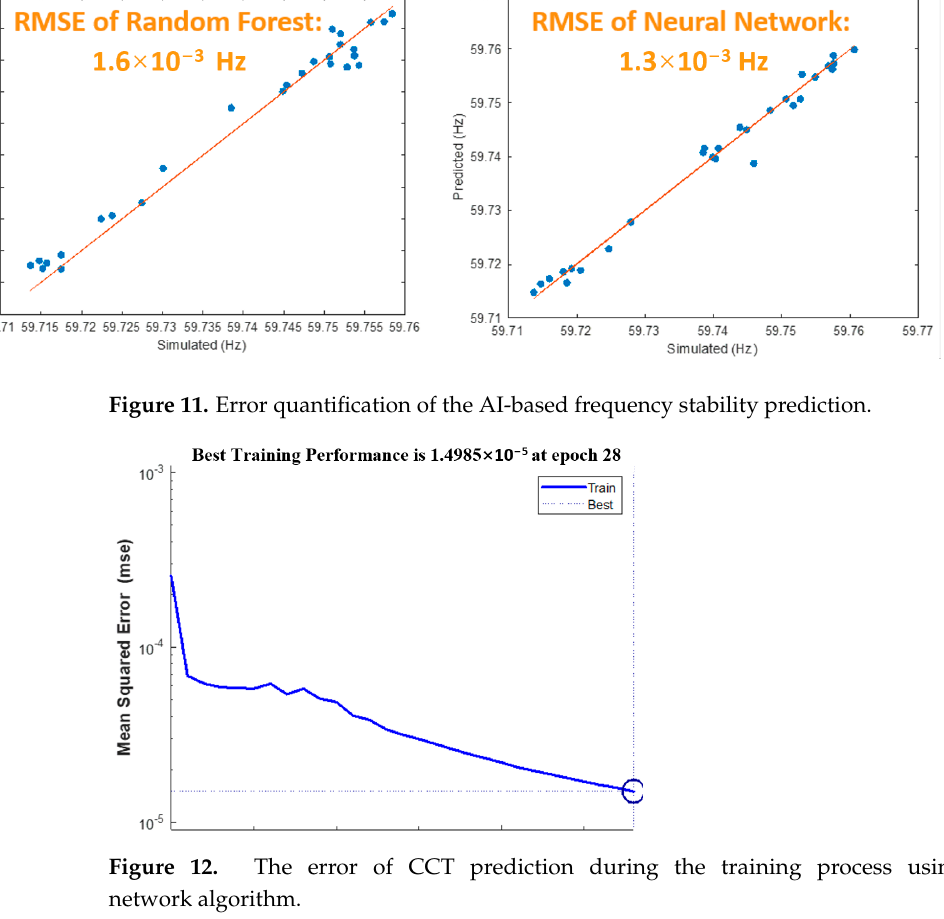
Figure 12. The error of CCT prediction during the training process using the neural network algo- rithm.